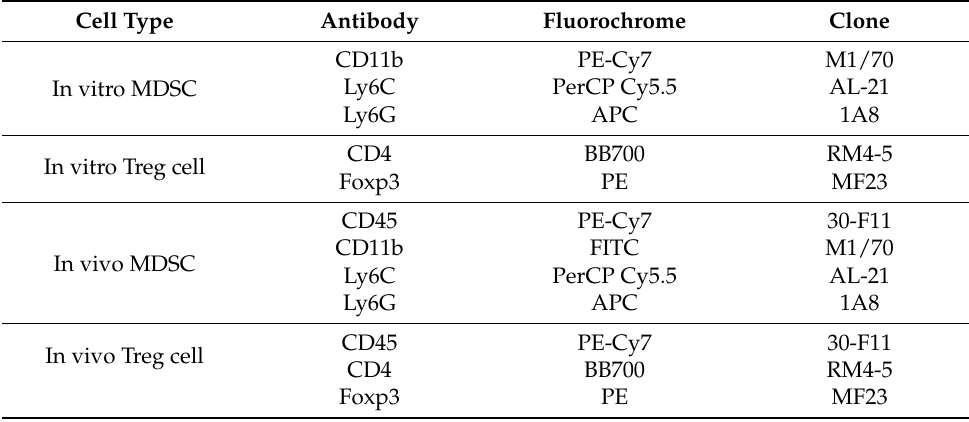
Table 1. Monoclonal antibodies used in flow cytometry